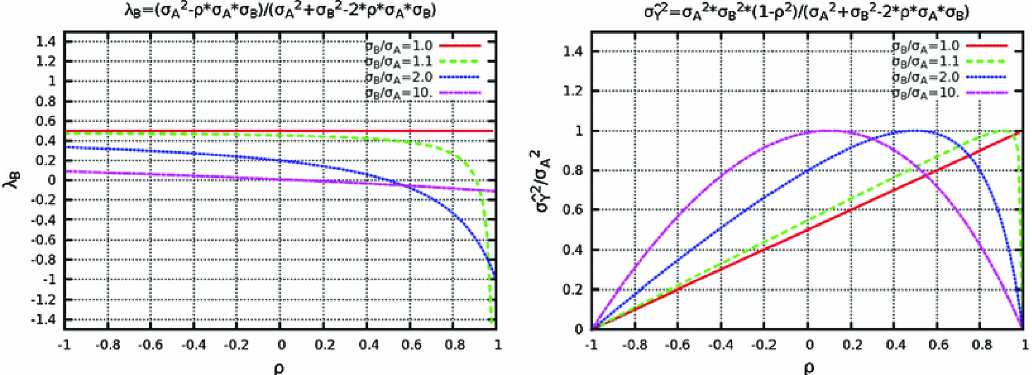
Figure 1. BLUE coe ffi cient for the second measurement w 2 (left; λ B in the original figure notation) and combined BLUE variance σ 2 (right; σ 2 in the original figure notation) as a function of the correlation ρ between two ˆ θ ˆ Y measurements 1 and 2 for various fixed values of the ratio σ 2 /σ 1 ( σ B /σ A in the original figure notation). The figure is from ref.